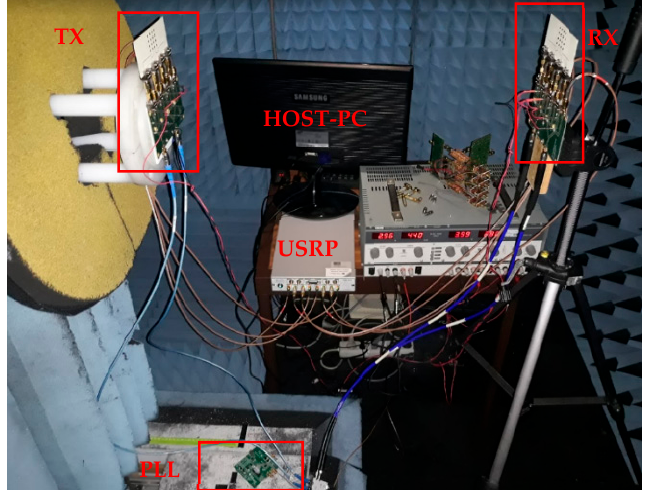
Figure 12. Experimental setup to measure antenna radiation pattern.